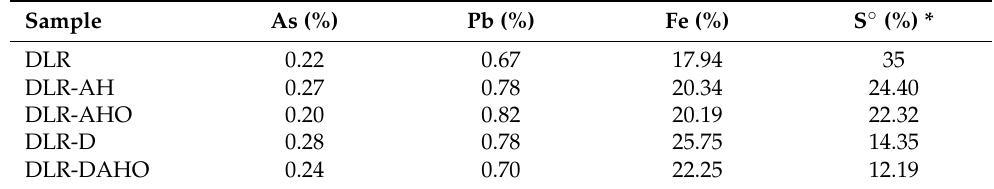
Table 3. Chemical analysis of DLR.